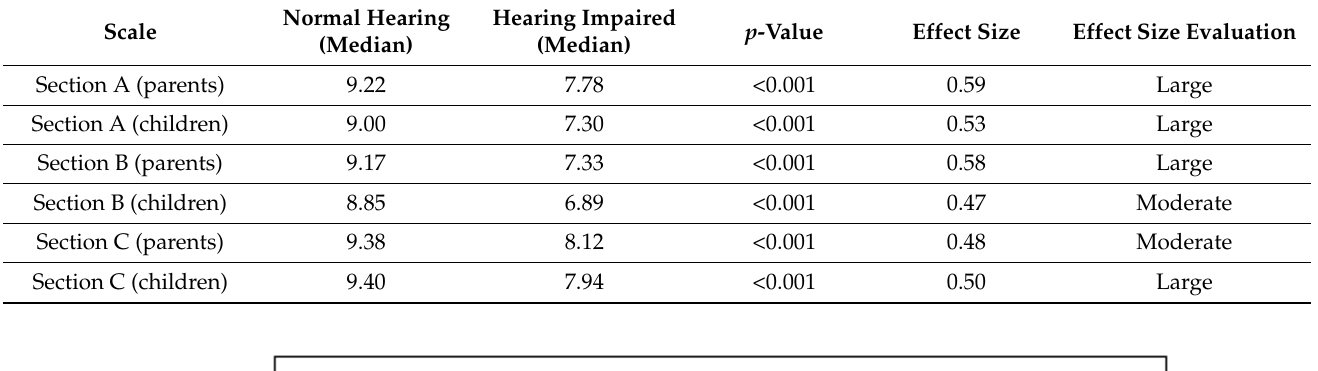
Table 3. SSQ subscales for parents and children in the normal-hearing and hearing-impaired children